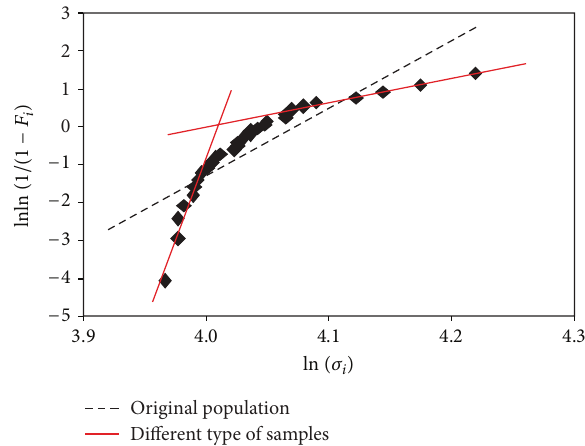
Figure 4: The Weibull plot of strength of glazed Vita VMK 68 specimens. The dashed lines indicate the original population, and solid lines show the effect of R-curve